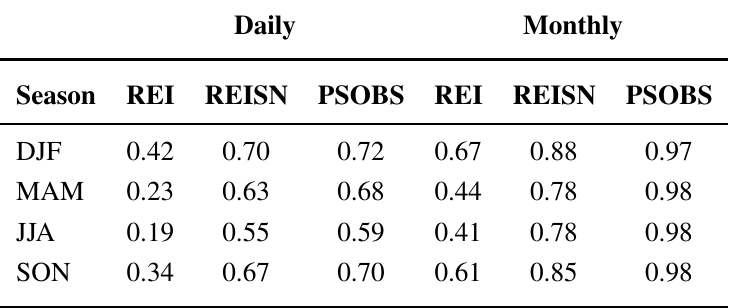
Table 2. Domain average results for correlations of precipitation towards E-OBS daily and monthly data.